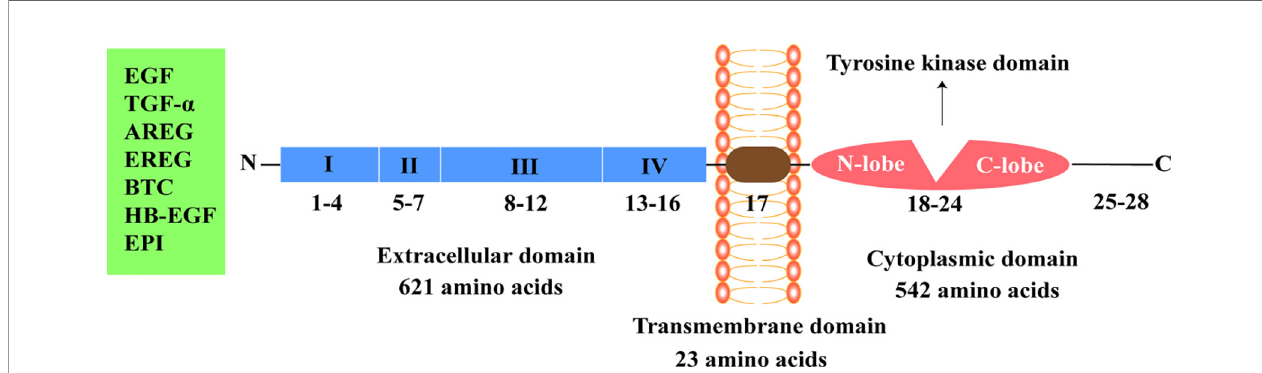
FIGURE 1 | Epidermal growth factor receptor structure. EGF, epidermal growth factor; TGF- a , transforming growth factor- a ; AREG, amphiregulin; EREG, epiregulin; BTC, betacellulin; HB-EGF, heparin binding epidermal growth factor-like growth factor; EPI,